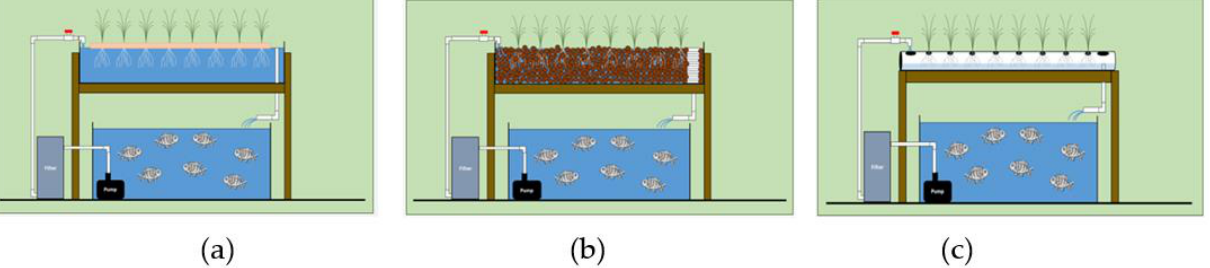
Figure 2. Popular aquaponics systems: ( a ) deep water culture (DWC), ( b ) ebb and flow system, ( c ) nutrient film technique system. These diagrams are sourced from [103]. Table 4. Aquaponics system components: relevance, considerations for selection and examples.